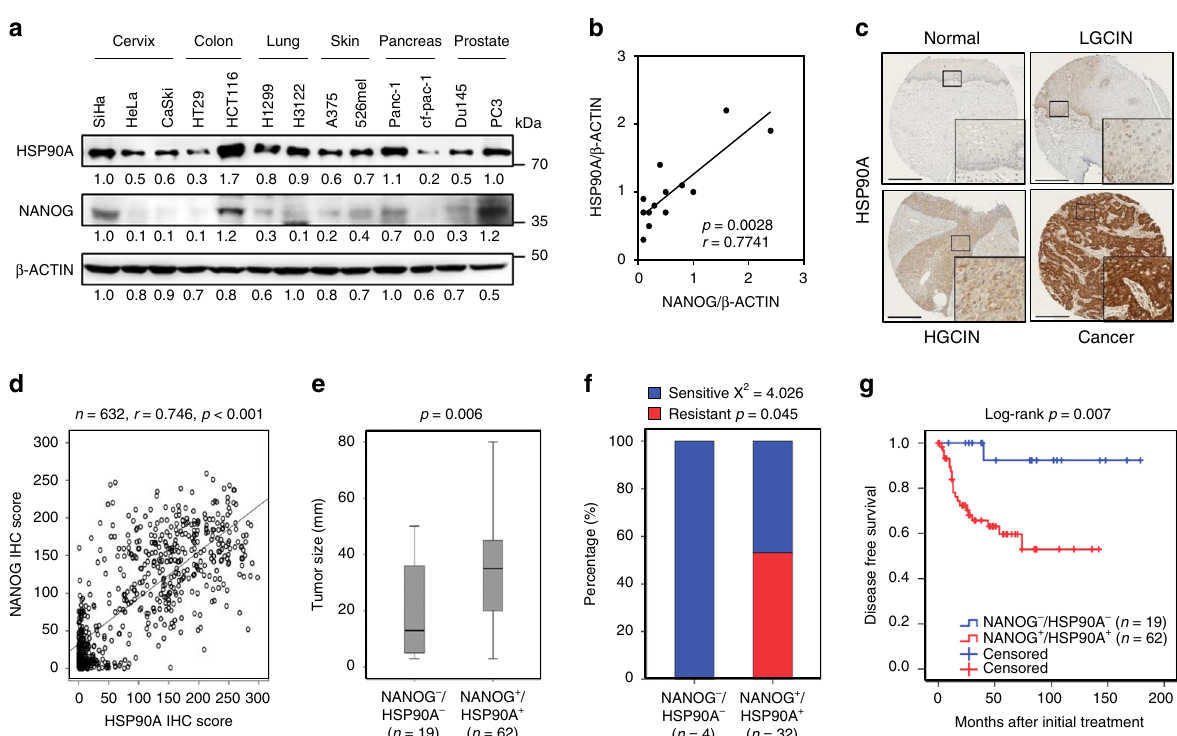
Fig. 3 NANOG – HSP90A axis is conserved across various human cancer types. a Protein levels of NANOG and HSP90A in various human cancer cells were determined by immunoblotting. This experiment was performed in triplicate. b Correlation between NANOG and HSP90A level normalized by β - ACTIN level in various human cancer cells (Spearnan r = 0.7741, p = 0.0028). c Representative images of IHC staining of HSP90A in cervical tissue from normal ( n = 328), LGCIN ( n = 65), HGCIN ( n = 160), and cervical carcinoma ( n = 151) patients. Scale bar shown is 250 µ m. LGCIN low-grade CIN; HGCIN high-grade CIN. d Correlation between NANOG and HSP90A in patients with cervical cancer (Spearnan r = 0.746, p < 0.001). e and f Combined level of NANOG + /HSP90A + was signi fi cantly associated with large-sized tumors e and chemoradiation resistance f in patients with cervical cancer. Chemoradiation resistance was calculated only cases with available information of chemoradiation response. g Patients with NANOG + /HSP90A + level displayed worse disease-free survival ( p = 0.007) than patients with NANOG − /HSP90A − level. Cut-off value of NANOG + and HSP90A + are 160 and 127, respectively. The p -values were determined by Mann – Whitney U test e and f and Log-rank (Mantel – Cox) test g or spearman correlation ( r ) b and d . In the box plots, the top and bottom edges of boxes indicate the fi rst and third quartiles, respectively; the center lines indicate the medians; and the ends of whiskers indicate the maximum and minimum values, respectively. Source data are provided as a Source Data fi